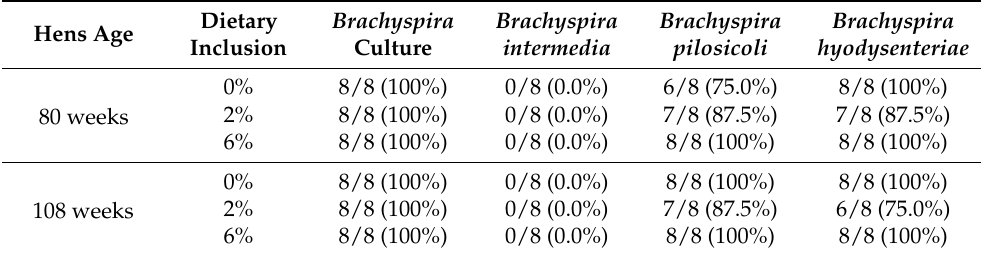
Table 3. Brachyspira detection in cecal content according to the groups. Hens Age